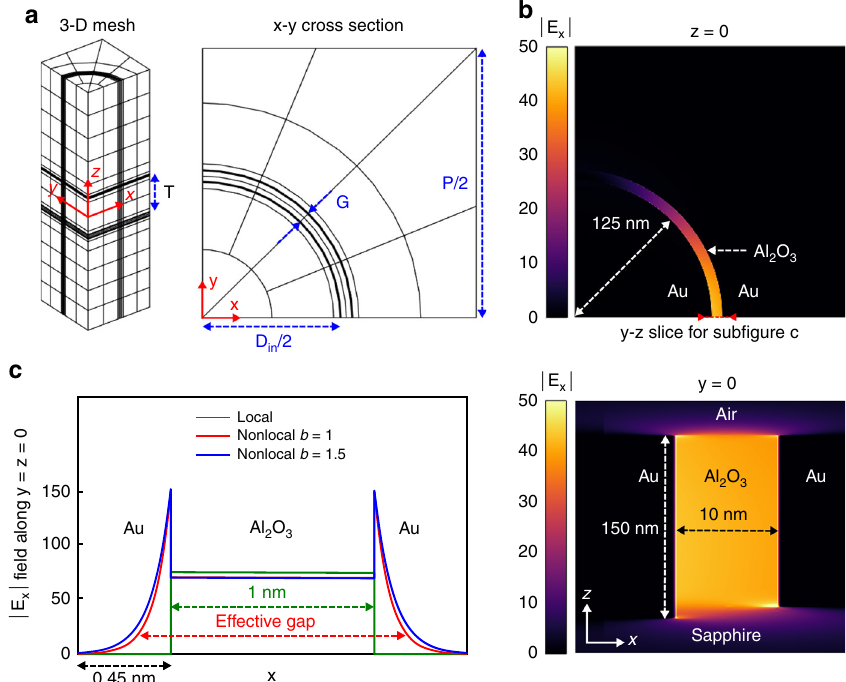
Fig. 2 Computational modeling of nonlocality in a coaxial nanoaperture. a 3-D mesh used for simulations consisting of 1960 hexahedra, with a z -constant cross section. Curved geometries are approximated with a cubic representation. Axes are provided for reference. b Magnitude of the fi eld enhancement on two cross sections for the 10 nm gap structure illuminated at resonant wavelength 2.87 µ m, computed with the nonlocal model ( b = 1). Plasmonic hotspots appear along y = 0 near the upper and lower metal tips. c Magnitude of enhancement computed along the x axis for the 1 nm gap and all the models, at the resonant wavelength for each case. Enhancement in the metal vanishes for the local model, whereas for the nonlocal model enhancement decays a skin depth proportional to the nonlocal parameter β . Skin depth does not depend on gap size, thus narrower gaps exhibit more prominent relative